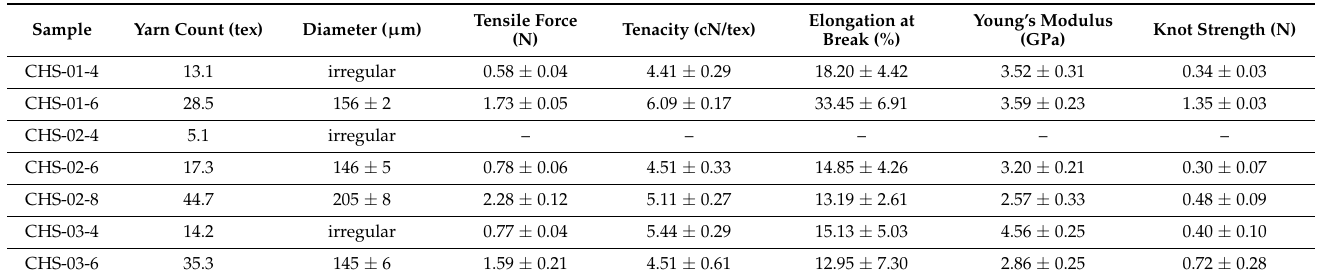
Figure 4. Scanning electron microscope (SEM) images of fibers made from chitosan and ionic liquid BmimOAc with different solids content: ( a ) CHS-02-4; ( b ) CHS-01-4; ( c ) CHS-03-4; ( d ) CHS-02-6; ( e ) CHS-01-6; ( f ) CHS-03-6. Table 1. Mechanical properties of fibers made from pure chitosan (90% degree of deacetylation) and ionic liquid BmimOAc with different solids